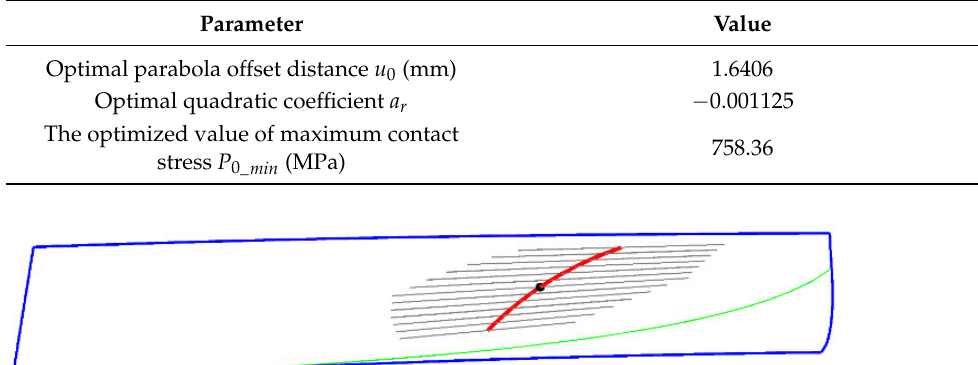
Table 3. Results of the optimization calculation for the modified helical face gear.